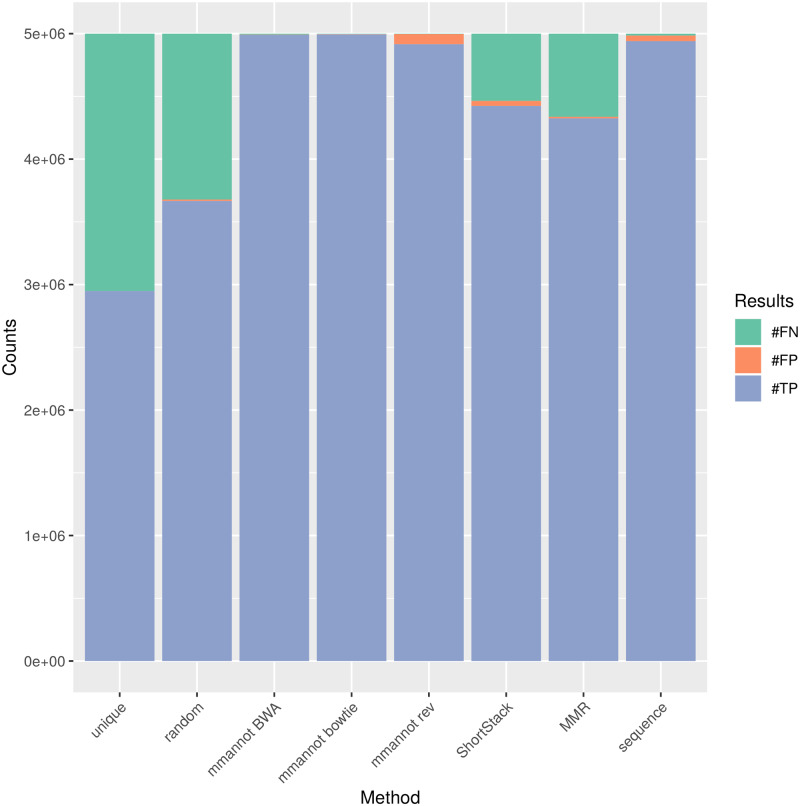
Results on the simulated data set.The number of true positives (#TP), false positives (#FP), and false negatives (#FN) are given for each method. We classified a multi-mapping read as true positive if at least one of the annotation given by mmannot is the correct one.